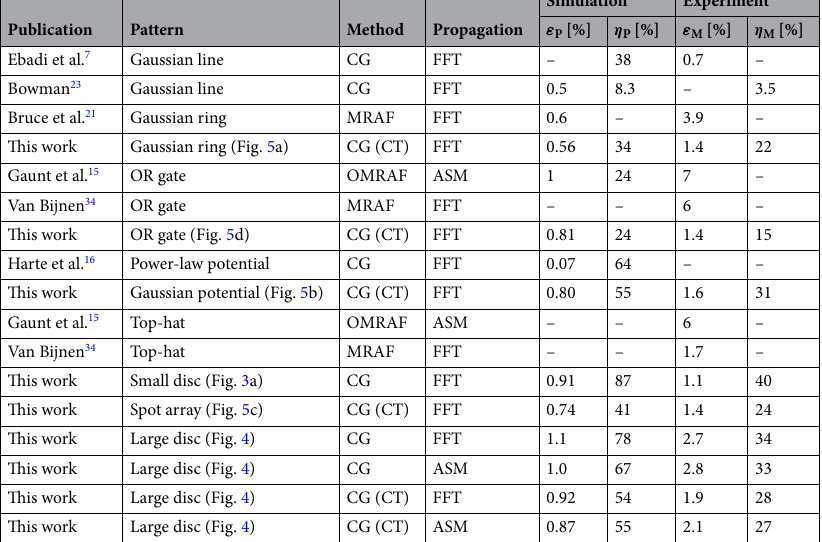
Table 1. Simulated and experimental errors and efficiencies of previous studies compared to this work. In the last four rows, we compare different methods using the disc-shaped target light potential (convergence shown in Fig.